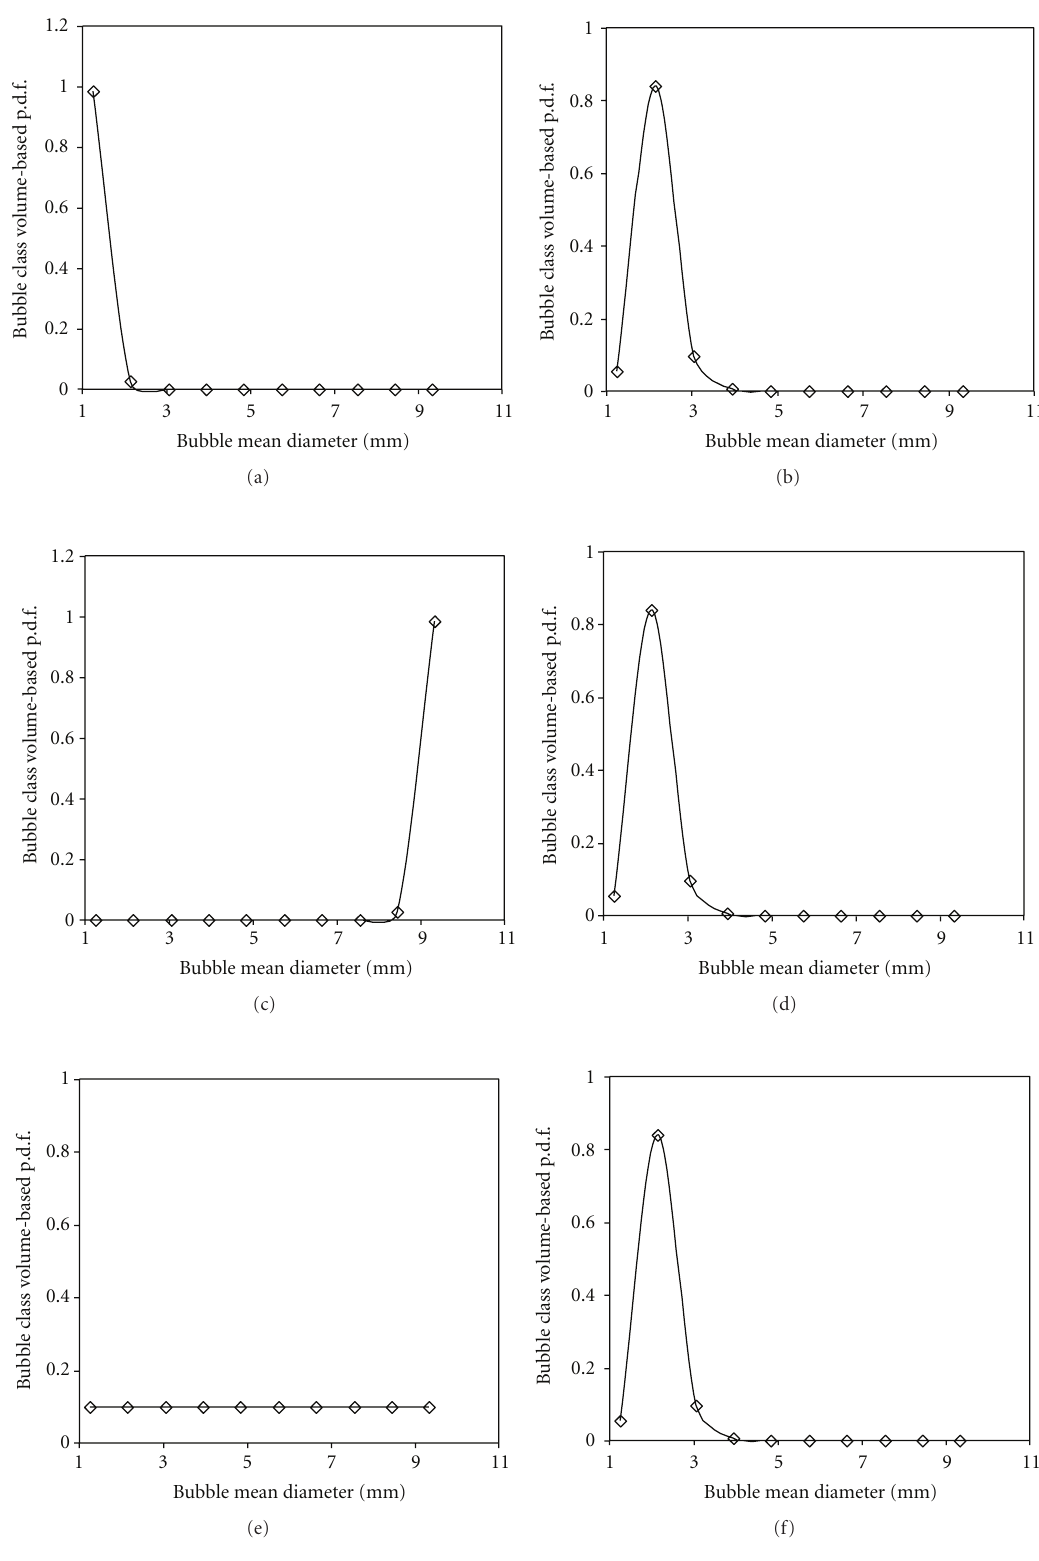
Figure 11: The bubble class volume-based p.d.f at inlet and exit of the pipe for superficial gas velocity is 0.25 m/s, superficial liquid velocity is 4.67 m/s, and average volume fraction is